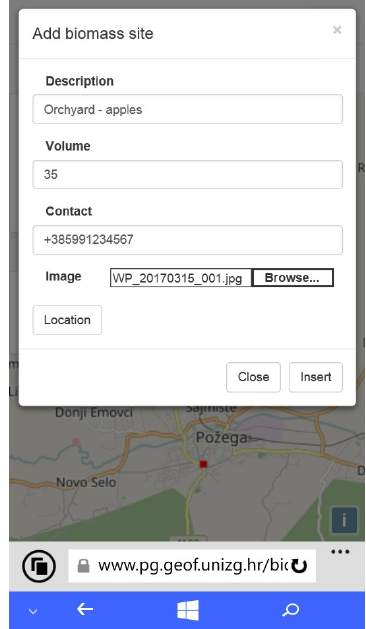
Figure 9. User interface of Waste2Fuel for adding a biomass sighting.